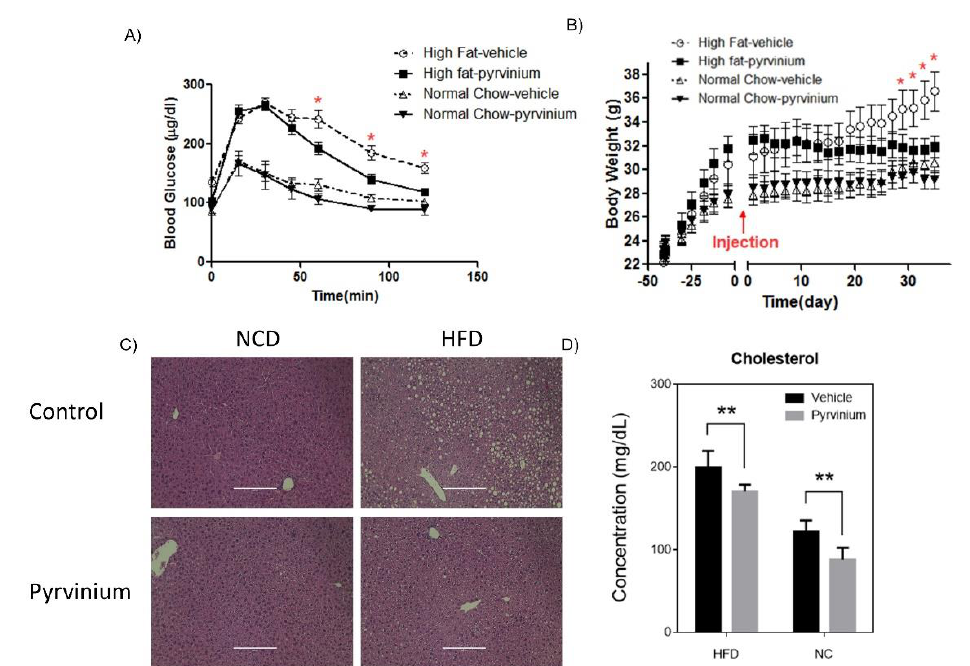
Figure 7. In vivo efficacy of pyrvinium in treatment of metabolic disorders in mice. ( A ) Glucose tolerance test in high fat diet (HFD) and normal chow diet (NCD)-fed mice treated with and without pyrvinium. C57BL/6J mice (n = 5 per group) were treated with pyrvinium for 1 month and fasted for 6 h prior to intraperitoneal injection of 1g/kg glucose for glucose tolerance test. The dose of pyrvinium was gradually escalated from 0.2 mg/kg to 0.5 mg/kg in a span of one month. ( B ) Body weight monitoring of the mice. Injection arrow indicates the start of pyrvinium administration. ( C ) Haematoxylin and eosin staining of liver tissues (20X image, scale bar is 400 µ m). ( D ) Effect of pyrvinium on serum cholesterol levels. Serum was collected postmortem. Data are presented as mean ± SD. * p < 0.05, ** p < 0.01.